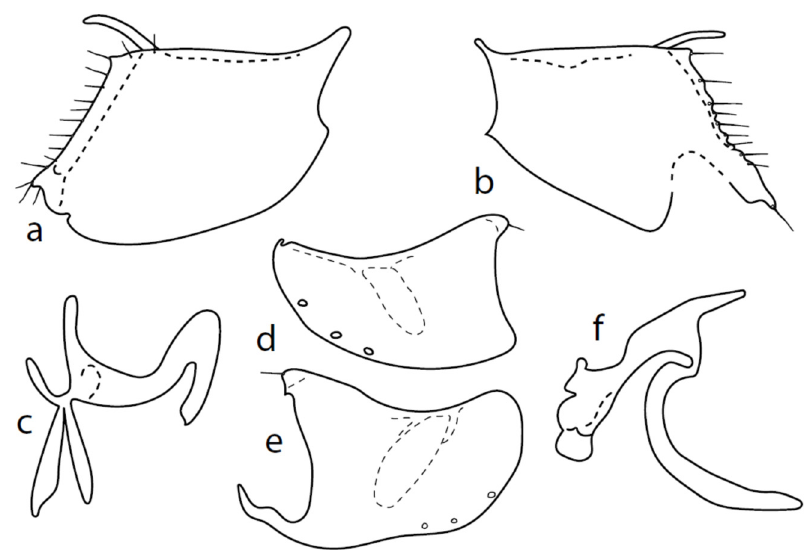
Figure 7. M. anomalus : ( a ) = right epandrial lamella, ( b ) = left epandrial lamella, ( c ) = postgonite from left, ( d ) = hypandrium from left, ( e ) = hypandrium from right, ( f ) = phallus from left. Description of genitalia (Figure 7): dorsal lobe of both (right and left) surstyli short and narrow, slightly bowed, (0.08–010 mm long; Figure 7a,b; however, some specimens were studied with somewhat longer lobes with very small and scarcely visible dorsal wart under Mag. 120X). Hypoproct moderately sclerotized, shorter than cerci. Middle lobe of right surstylus sharply triangle shaped, left—oblique rectangle to almost triangle-shaped, both very short and visible only in dorsal views (not illustrated here). Both apicodorsal lobes of hypandrium with short hair, right apicoventral lobe of hypandrium long, narrow and irregularly bow-shaped (folded at approximately middle, Figure 7e). Phallus (Figure 7f) simply bowed, straight at apex (rarely slightly narrowed), and phallic process narrow tipped and nearly straight (slightly differing in length and width between specimens). Right ventral postgonite lobe S-shaped (Figure 7c). Genitalia are strikingly similar to Nearctic M. obscurus ([6], Figure 69–74) and further studies are necessary to elucidate their possible